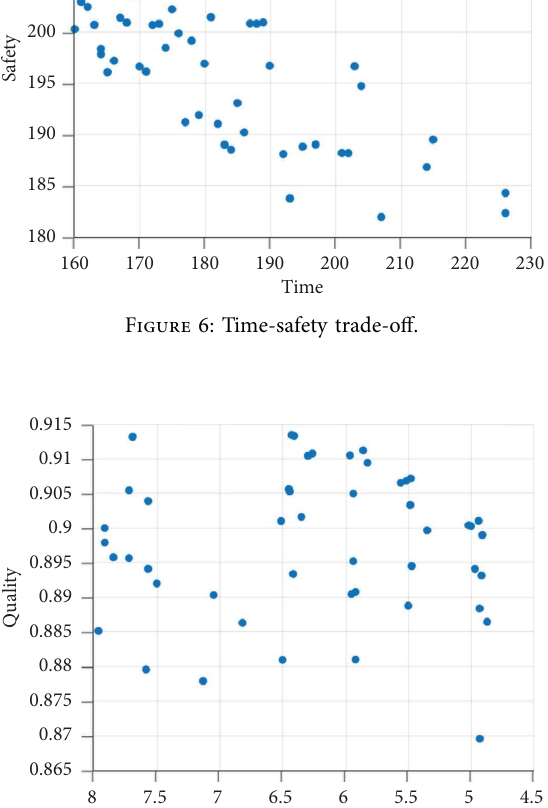
Figure 5: Time-quality trade-of.